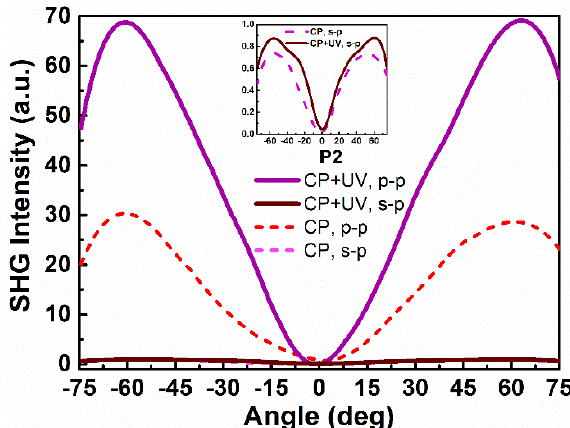
Figure 6. Second harmonic generation intensities as a function of rotation angle of polymers P1, P2, and P3, after corona poling (CP, dash line), UV–irradiation (UV, solid line) and with ZnO nanoparticles (NPs, dots) in an s–polarized and p–polarized laser beam.